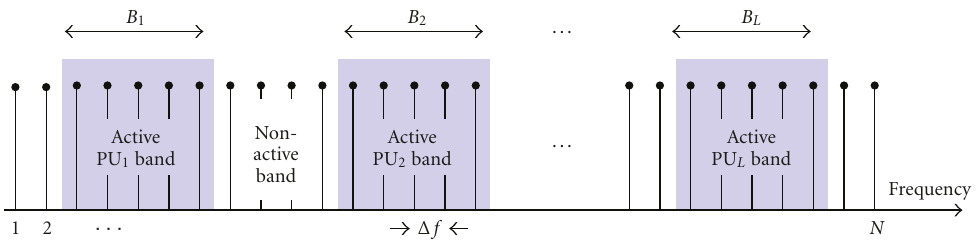
Figure 2: Frequency distribution of the active and nonactive primary